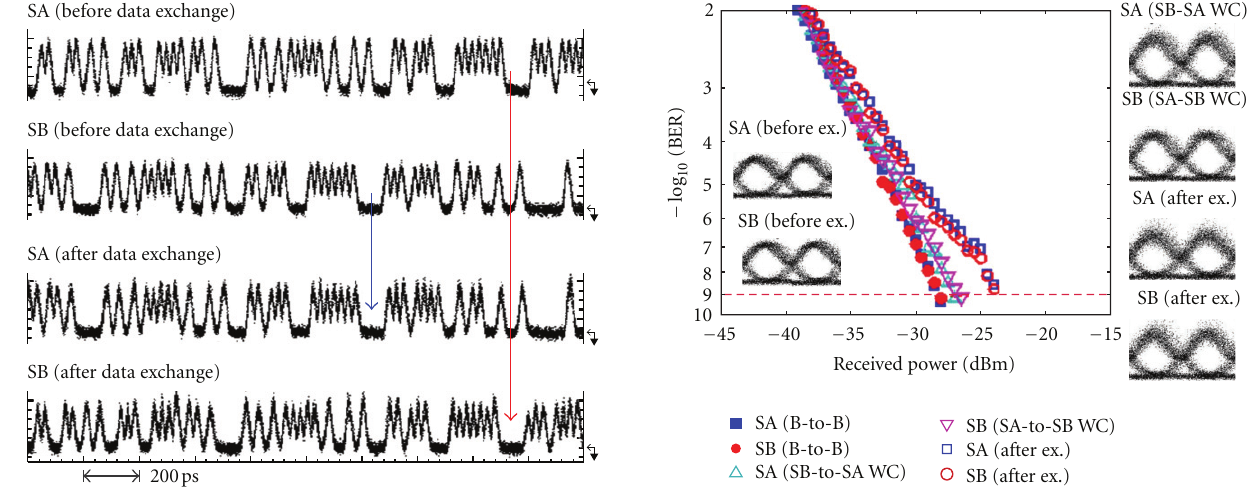
Figure 13: Measured destructively demodulated AMI waveforms for data exchange between two 40Gbit/s NRZ-DPSK signals.